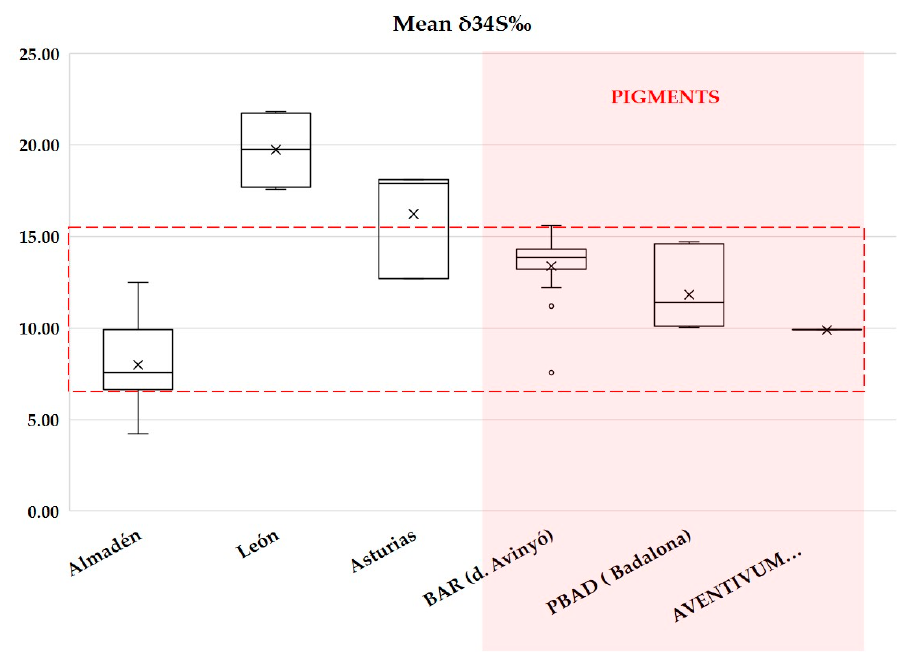
Figure 4. Mean and standard deviation between the minimum and maximum values for all the mining areas and the pigments.